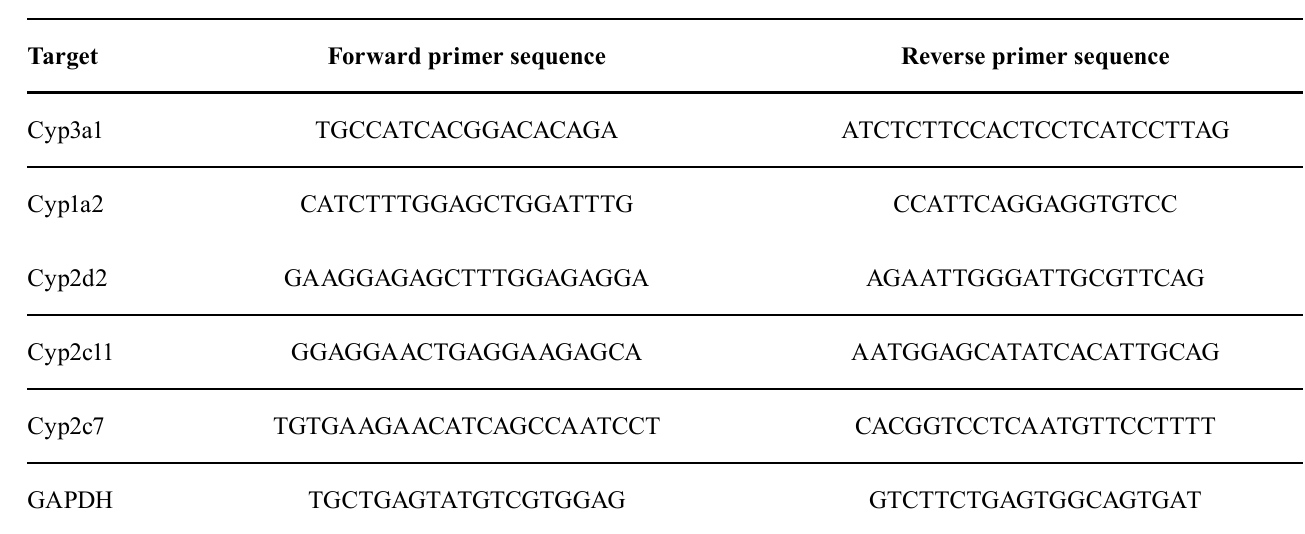
TABLE II – Oligonucleotide primers used for real-time RT-qPCR